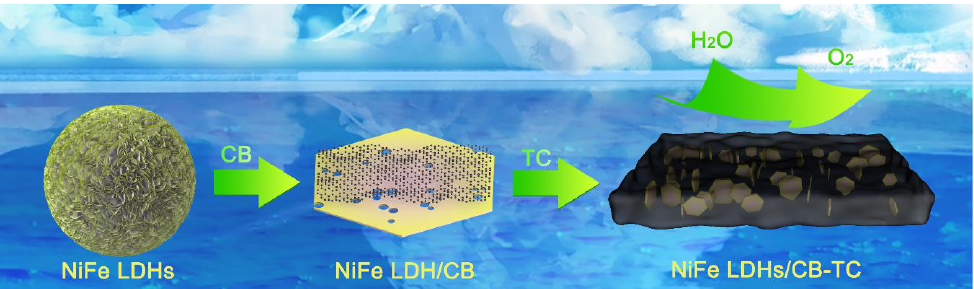
Figure 1. A schematic of the synthesis process of NiFe layered double hydroxides (NiFe LDHs) / carbon black (CB)-trisodium citrate (TC) .